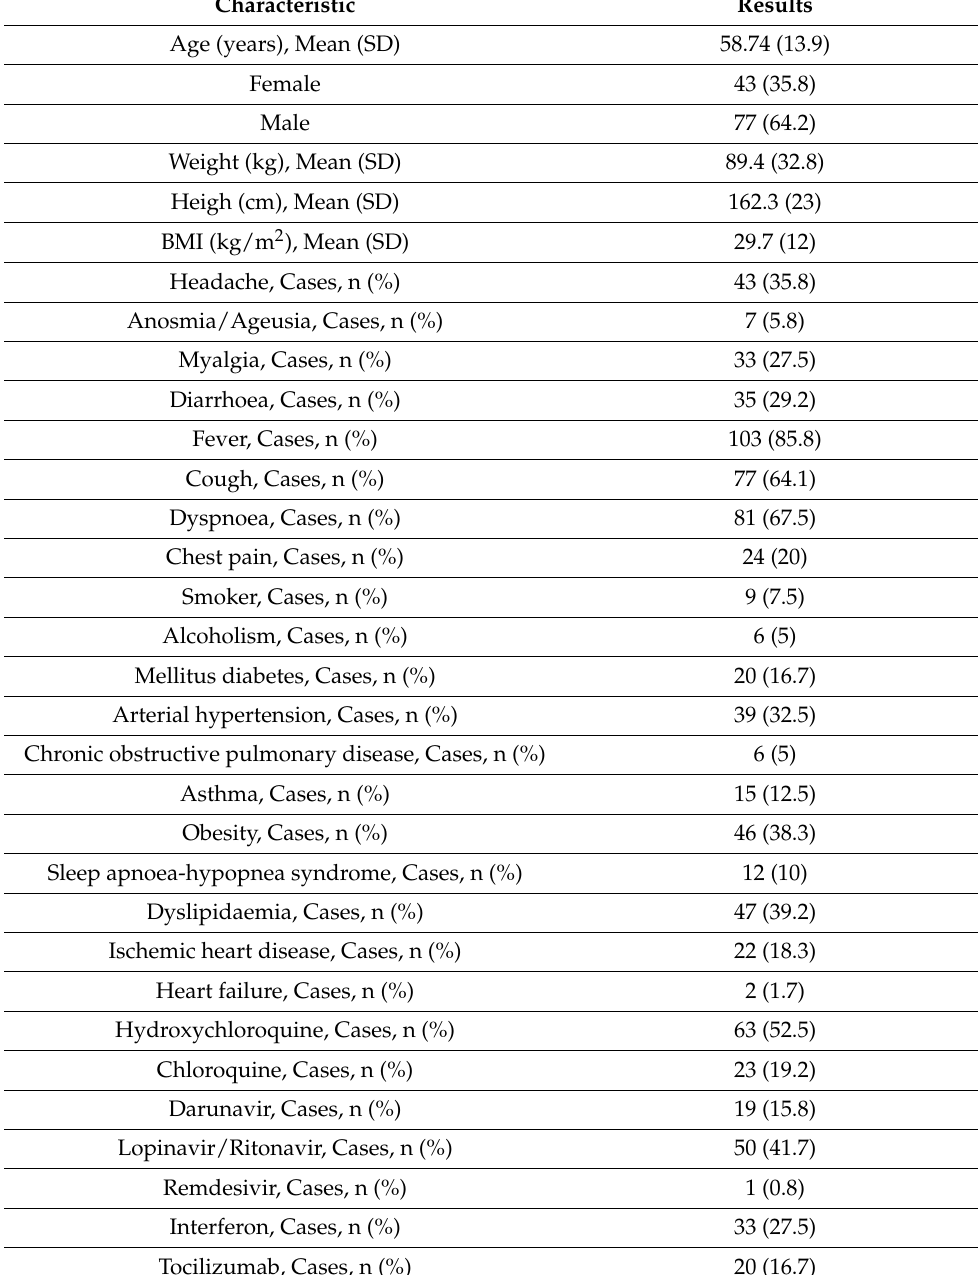
Table 1. Characteristics of patients included in the sample, management procedures and treatments of patients included in the